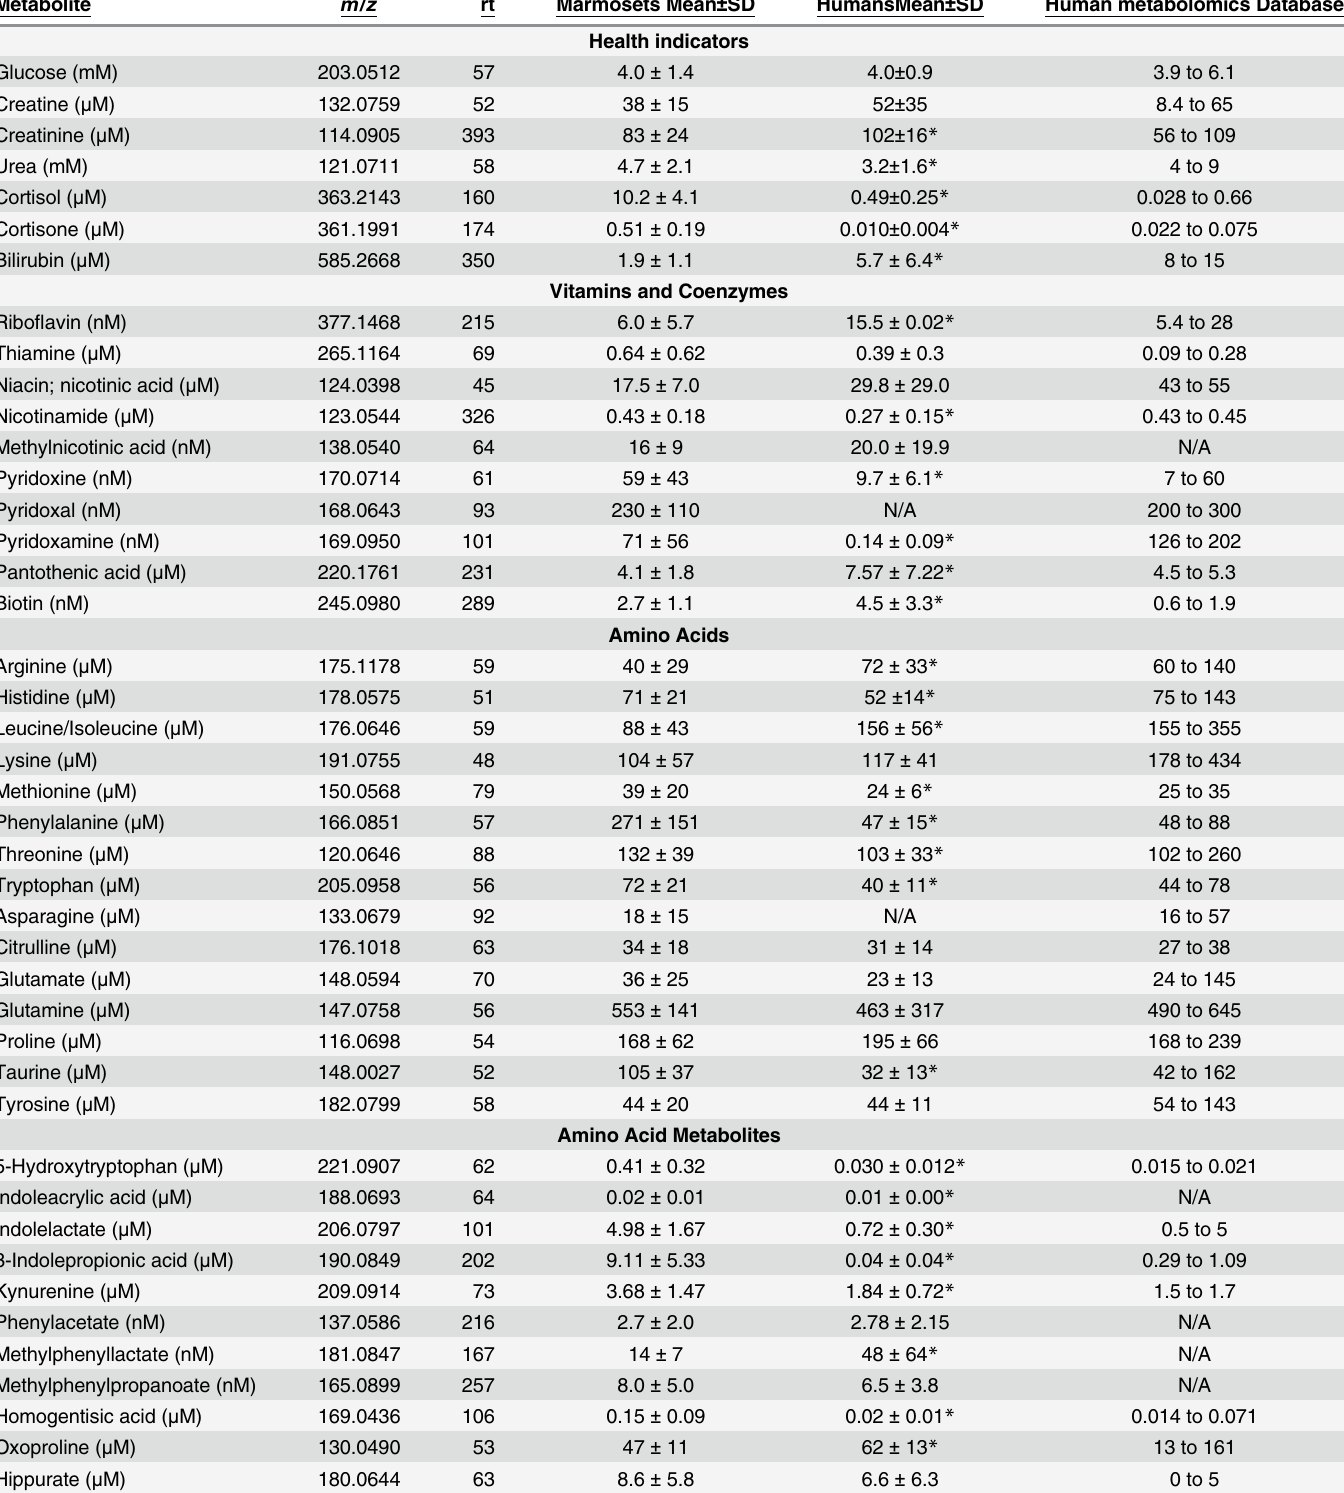
Table 1. Plasma metabolite concentrations in common